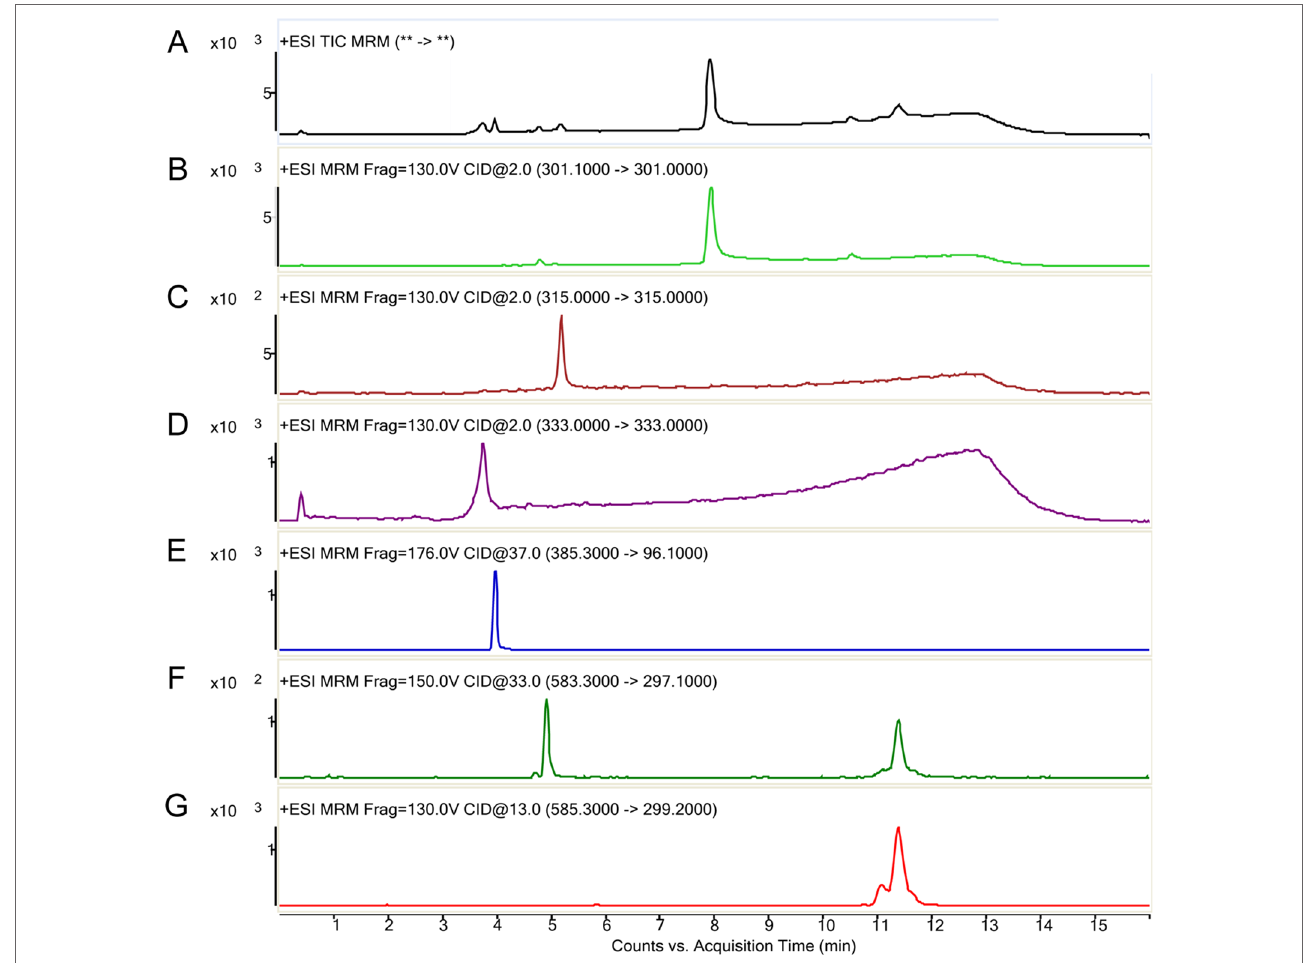
FIGURE 4 | Representative LC-MS/MS chromatographs of bilirubin and its metabolites (counts vs. acquisition time). The various ions detected are indicted in the order of their elution time. (A) Total ion current; (B) Reaction monitoring transitions of M/Z 301; (C) Reaction monitoring transitions of M/Z 315; (D) Reaction monitoring transitions of M/Z 333; (E) Multiple-reaction monitoring of M/Z 385 → 96.1 (donepezil, internal standard); (F) multiple-reaction monitoring of biliverdin M/Z 583 → 297; (G) multiple-reaction monitoring of bilirubin M/Z 585 → 299.